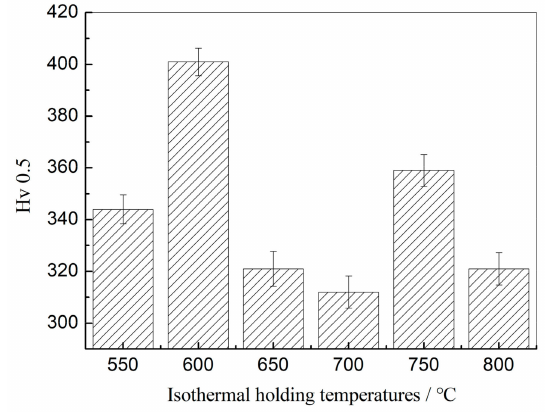
Figure 4. E ff ect of isothermal temperature on Vickers